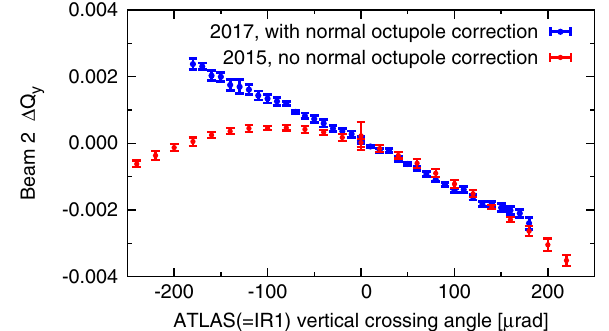
FIG. 11. Example of tune shift with crossing angle with (blue) and without (red) correction of normal octupole